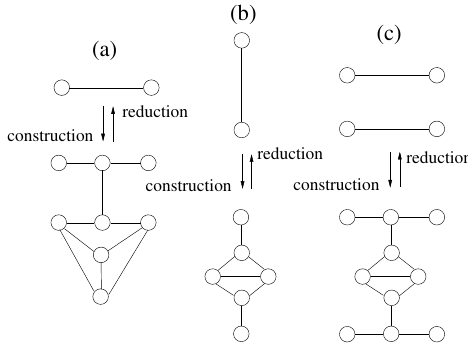
Figure 2: The construction operations for prime